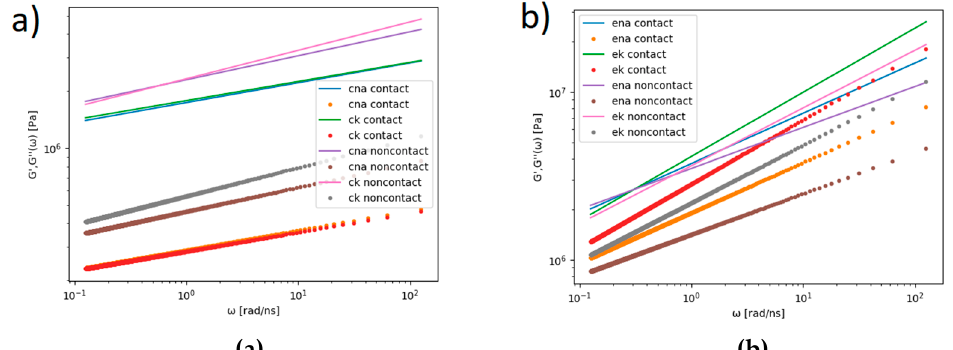
Figure 12. Complex viscoelastic moduli, G’—dot symbols and G”—cross symbols, for DPPC ( a ) and POPE ( b ). Abbreviations: ck—DPPC + KCl, cna—DPPC + NaCl, ek—POPE + KCl, ena—POPE + NaCl. Table 1. α parameters based on the fitting function presented in Equation (2). All results were obtained for the bilayers with the presence of the protein bound to it.